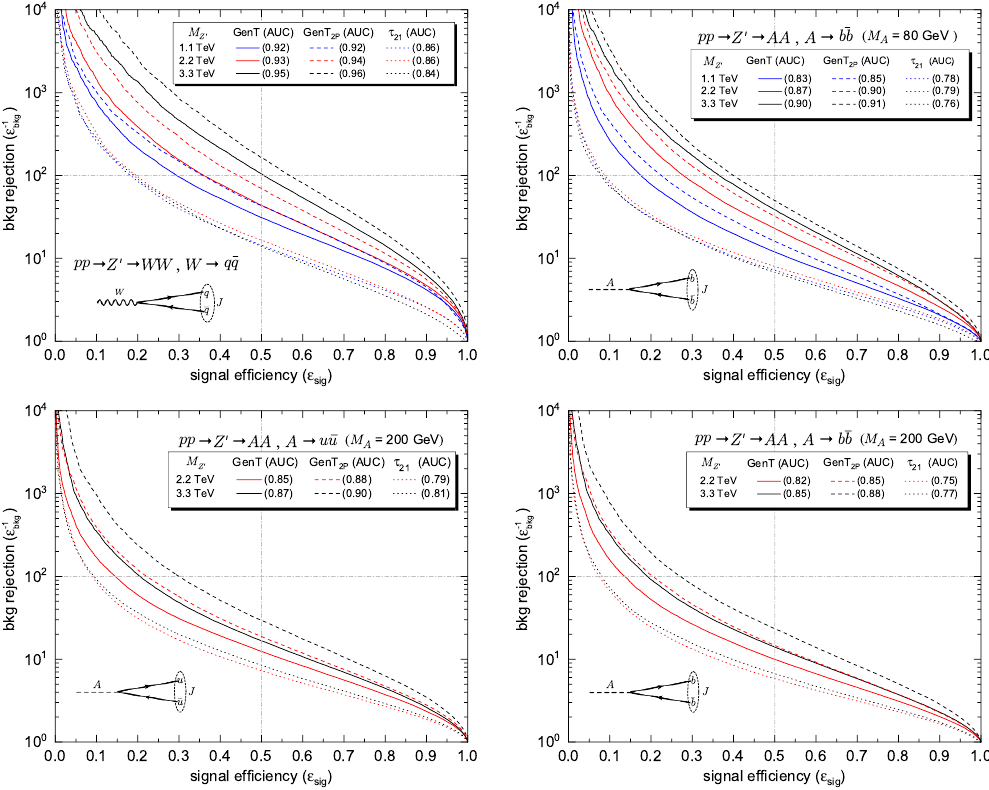
Figure 1 . ROC curves for two-pronged jet signals (for details see the self-explanatory legends and the main text).